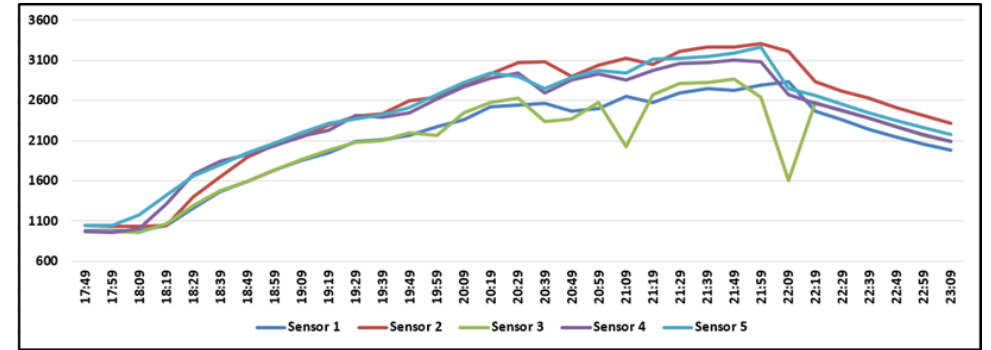
Figure 9. CO 2 concentration in the yurt between 6:00 p.m. and 11:00 p.m. on 9 February 2021 with five users inside.